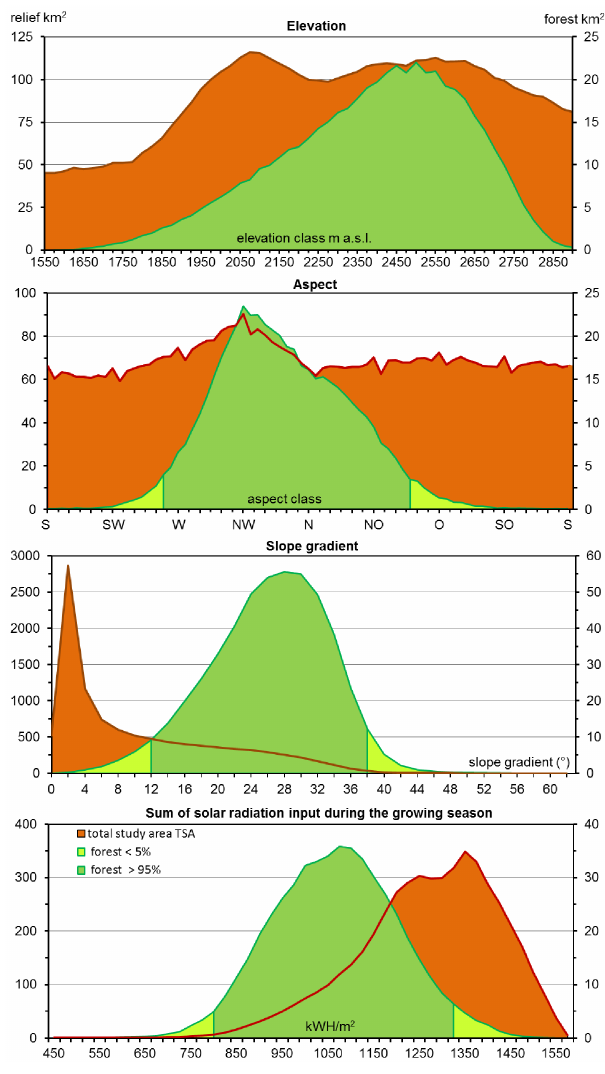
Figure 4. Frequency distribution of relief parameters in relation to actual forest area (AFA, green; in the diagrams of aspect, slope gra- dient and solar radiation input, the light green areas represent the standard deviation of 95 range excluded from PFA delineation) and total study area (TSA,